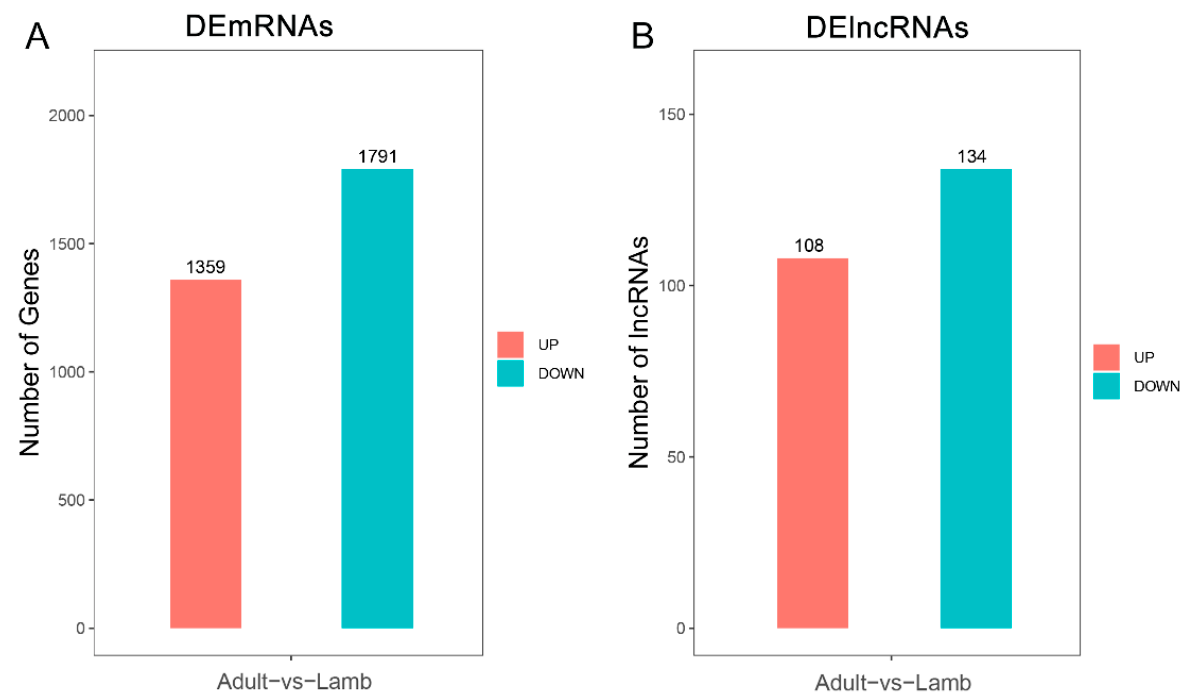
Figure 1. DE lncRNA and mRNA summary. ( A , B ) indicate the numbers of DEmRNAs and DElncRNAs, respectively; the red and green bars show the increased and decreased gene expression compared with the lamb group, respectively.